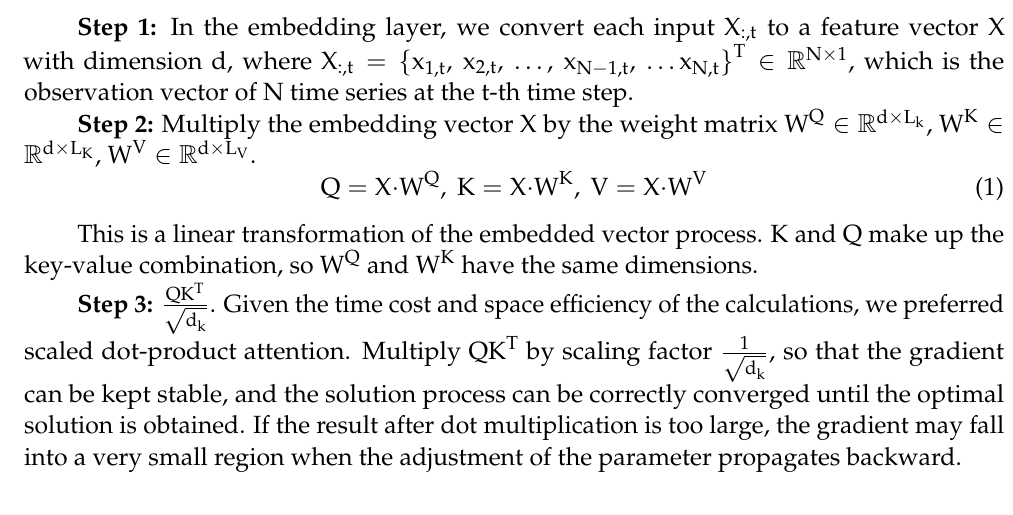
Figure 1. Scaled dot-product attention